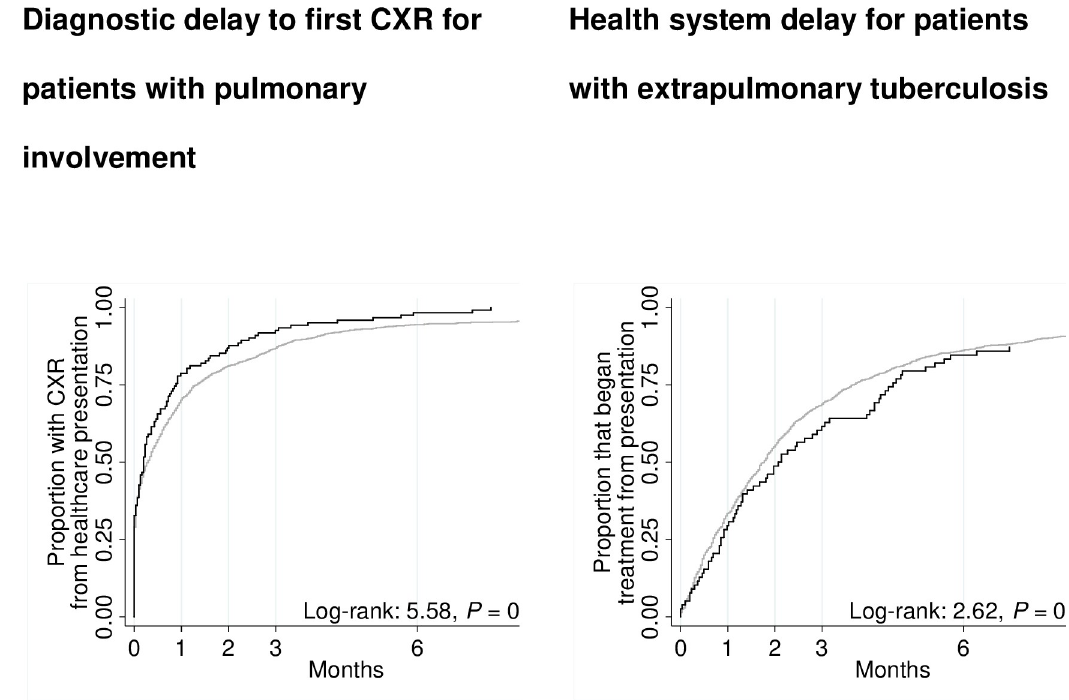
Fig 5. Kaplan-Meier curves in tuberculosis patients in Victoria, Australia from 2012 to 2019.